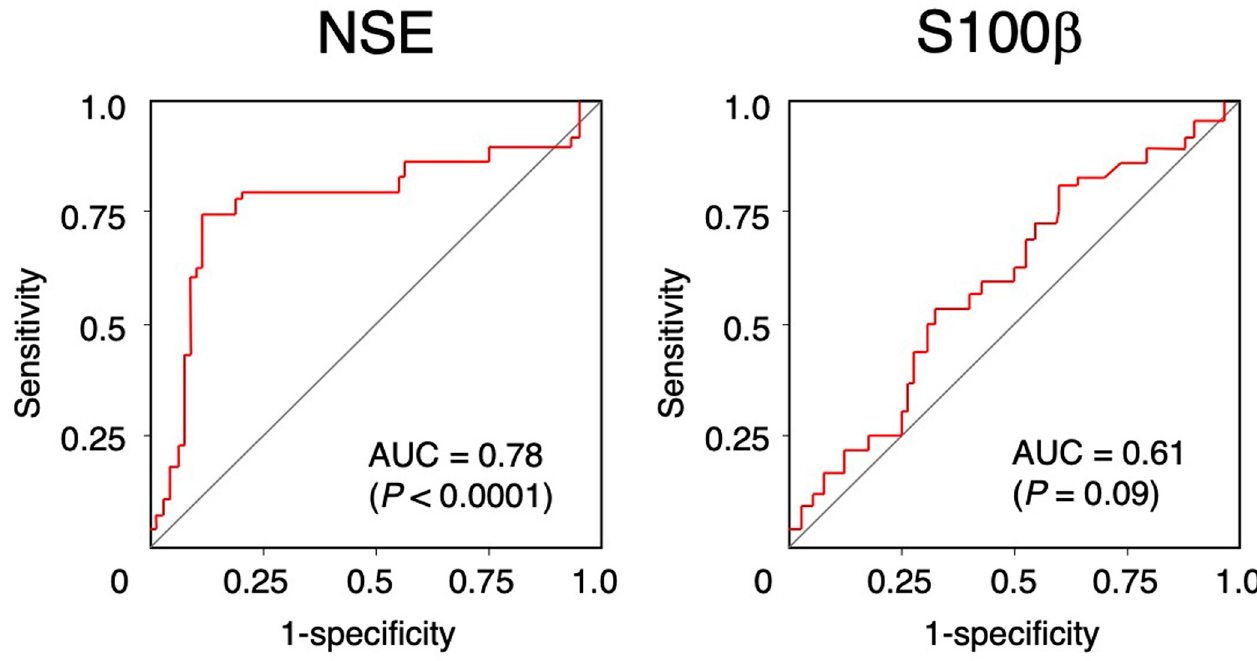
Fig 4. Receiver operating characteristic curves analysis of serum biomarker levels for detection of phosphorylated neurofilament heavy subunit. NSE, neuron-specific enolase; S100 β , S100 calcium-binding protein β .